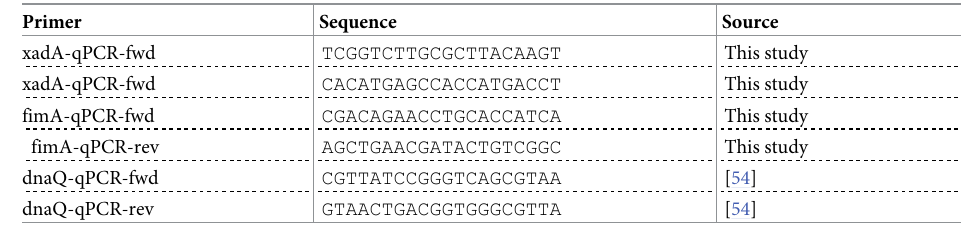
Table 1. List of primers used in this